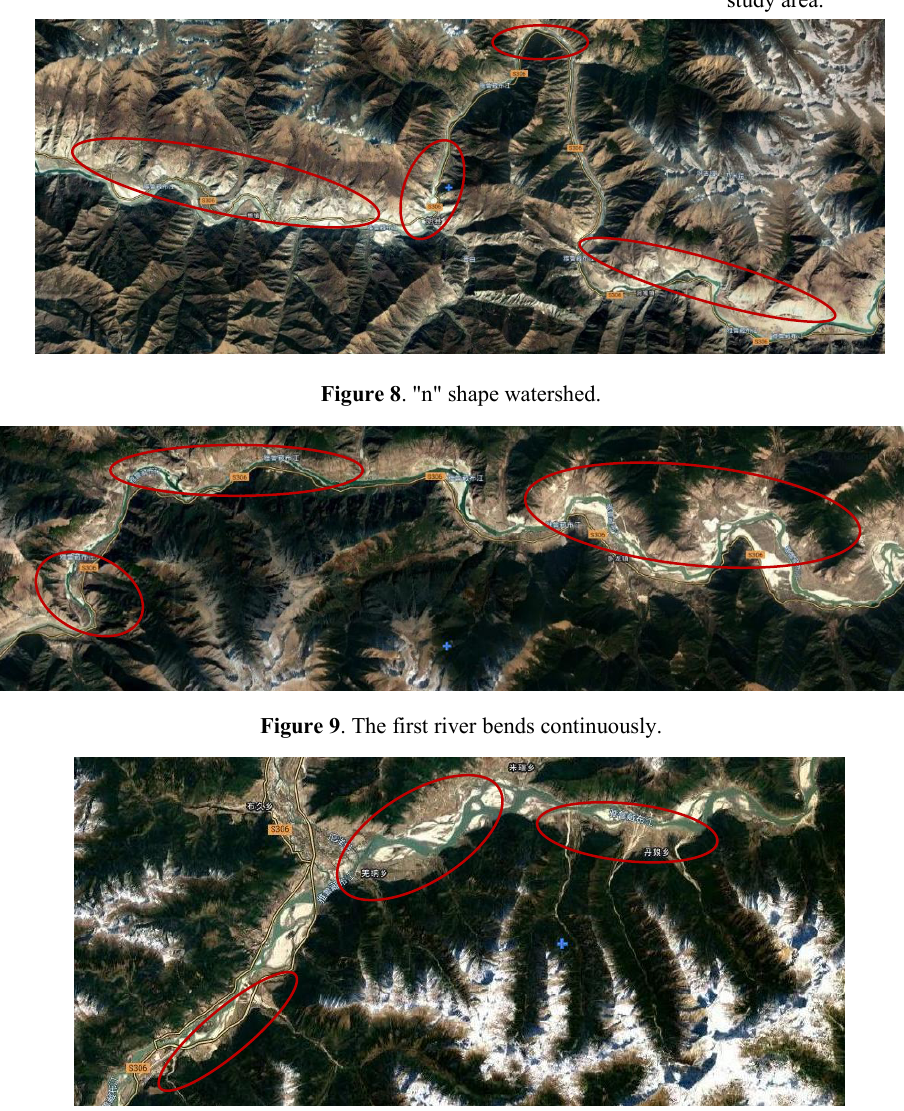
Figure 10 . The second river bends